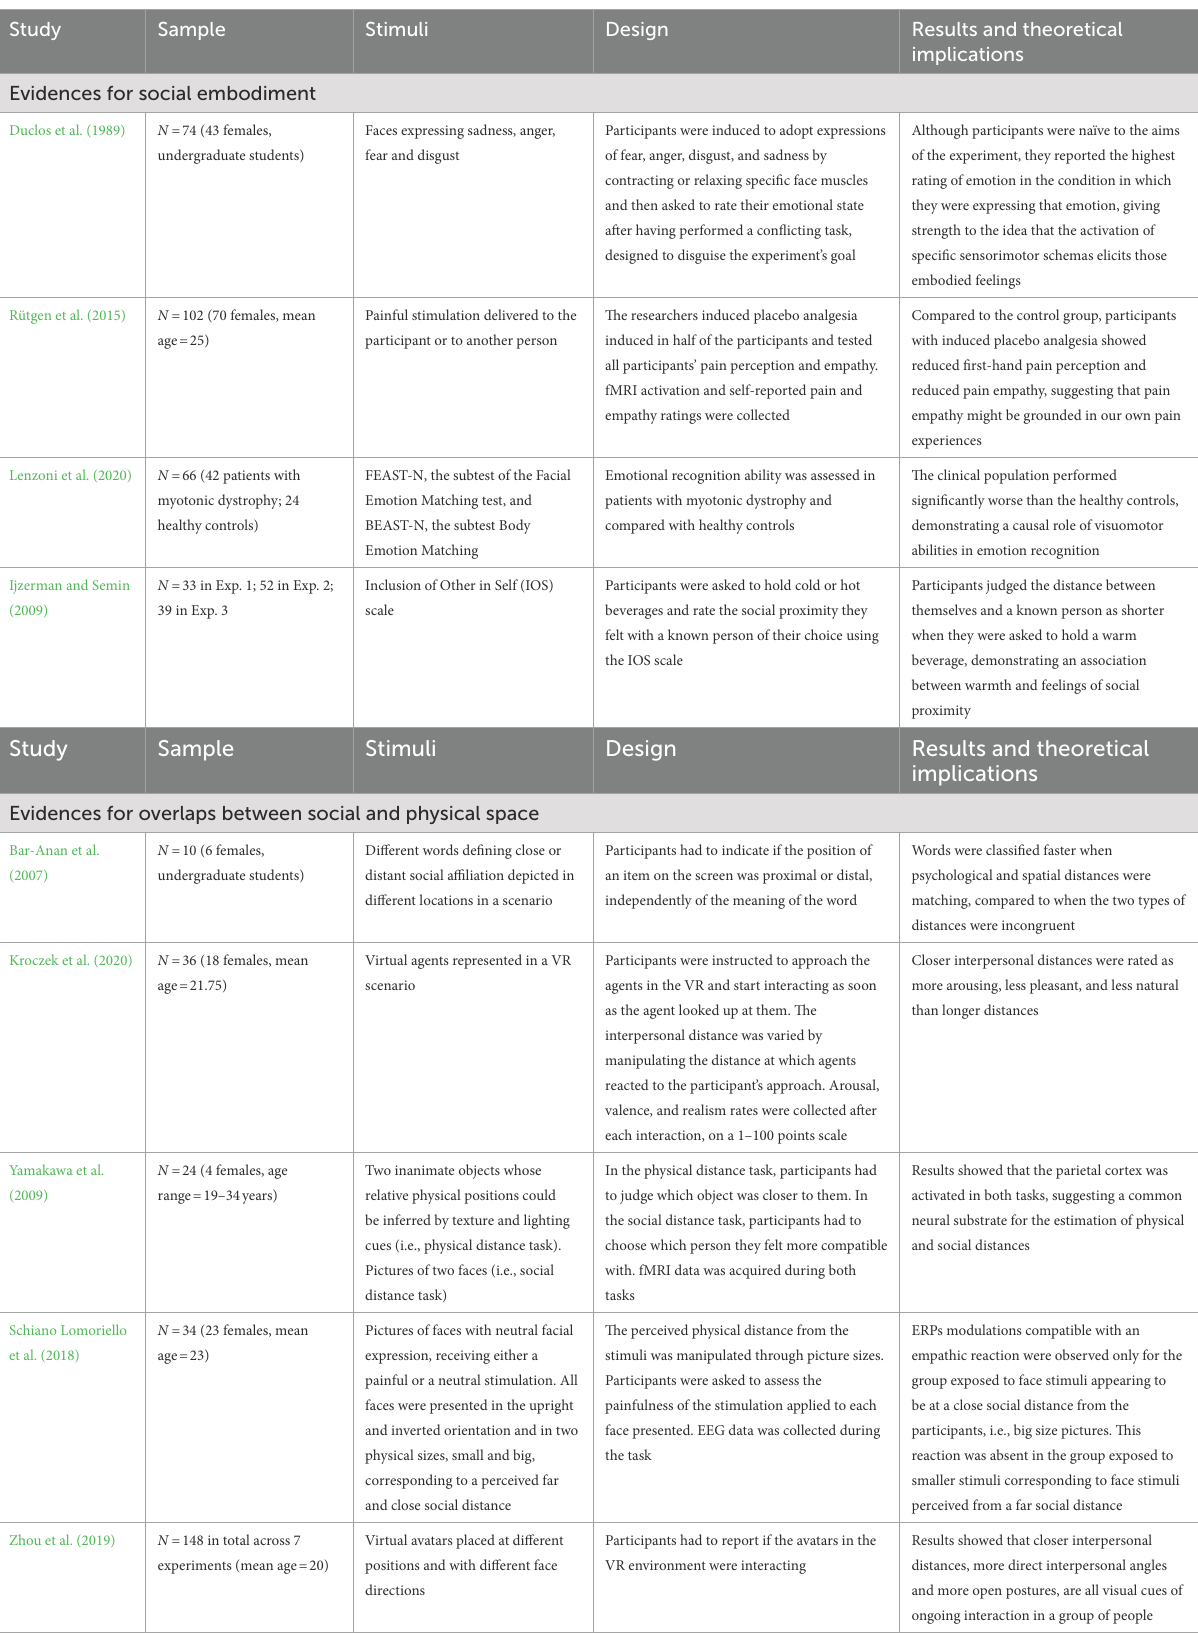
TABLE 2 Summary table of the studies cited in section